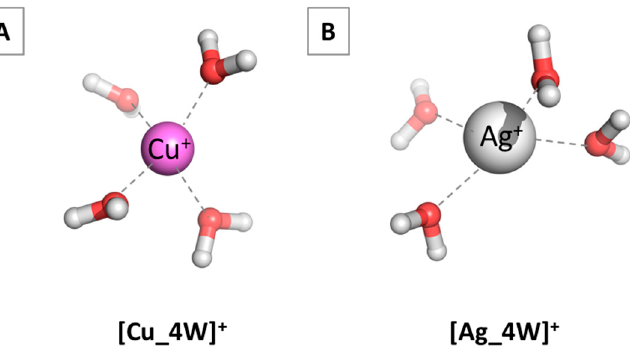
Figure 2. Theoretically modeled [Cu(H 2 O) 4 ] + ( A ) and [Ag(H 2 O) 4 ] + ( B ) complexes further denoted as as [M_4W] + [M_4W] + .